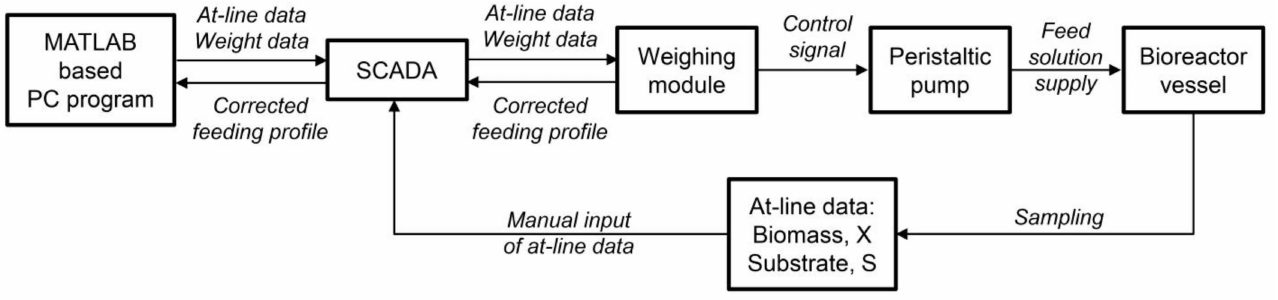
Figure 11. The information exchange diagram of the proposed MPC system